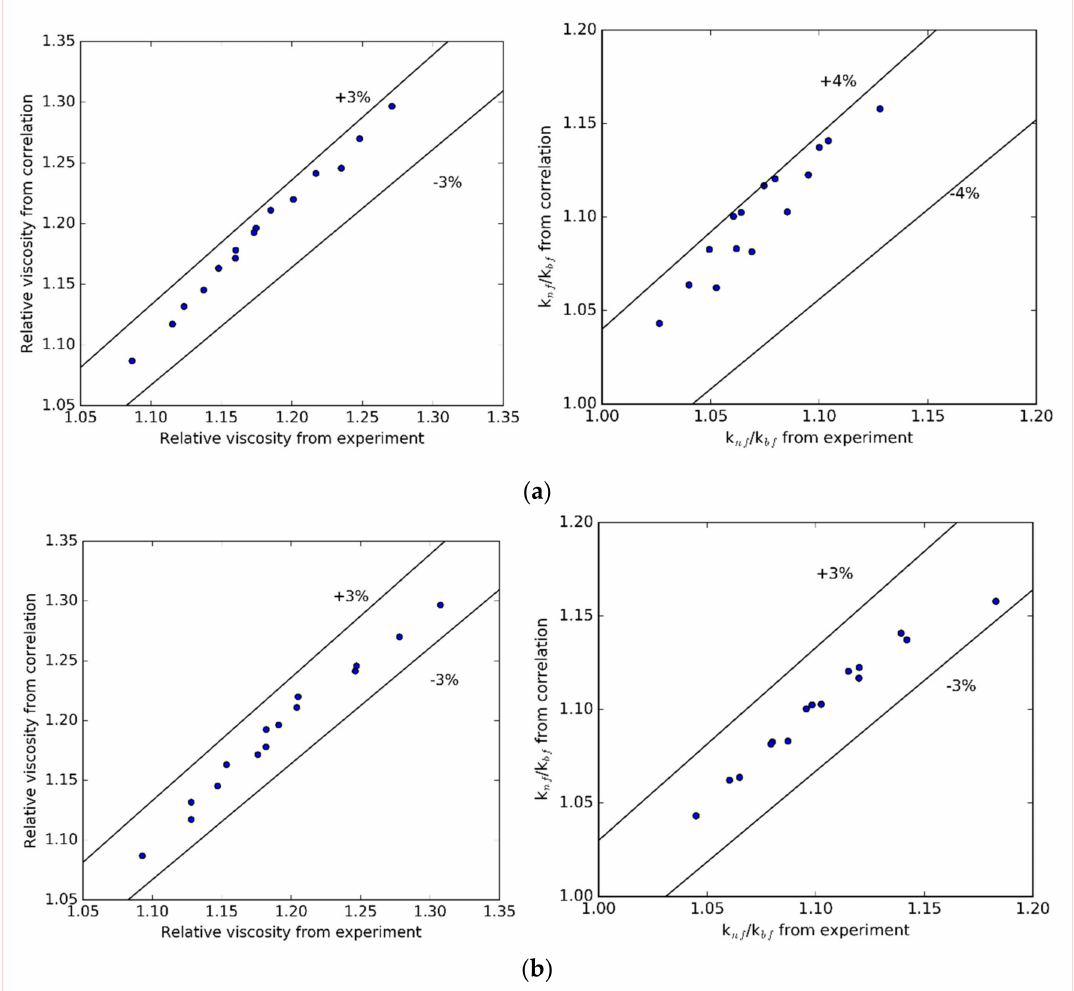
Figure 9. Comparison between thermal conductivity obtained from experiment and proposed correlation: ( a ) pH = 12, ( b )